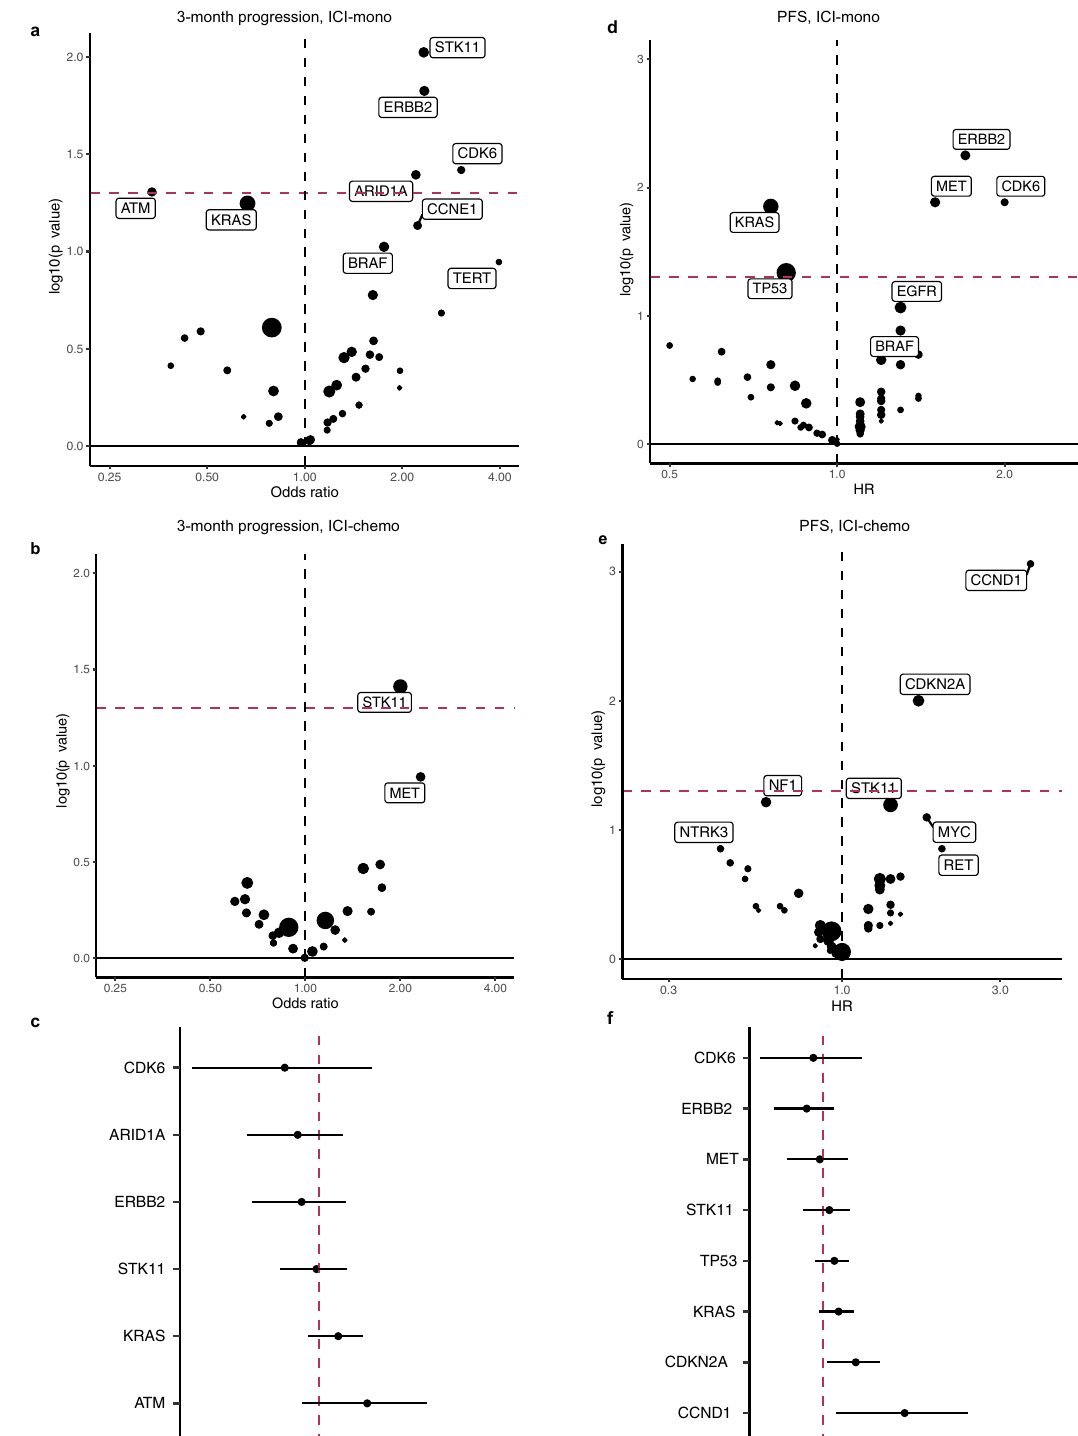
Fig. 4 | Association between gene alterations and outcomes in the MDACC primary cohort ( n =735 with genomic data). a , b Volcano plot from univariate logistic regression depicting odds ratio (x-axis) versus − log 10 ( P -value) ( y -axis) for 3-month progression in patients treated immune checkpoint inhibitors (ICI) as a monotherapy(ICI-mono)or b withchemotherapy(ICI-chemo);logisticregression modelswithunadjustedeffectwereappliedtocalculatetheoddsratioand p values. c Treatment effect analyses of gene subgroups on 3-month progression. Data are presented asthe treatment effectestimates with error bars showing the lower and